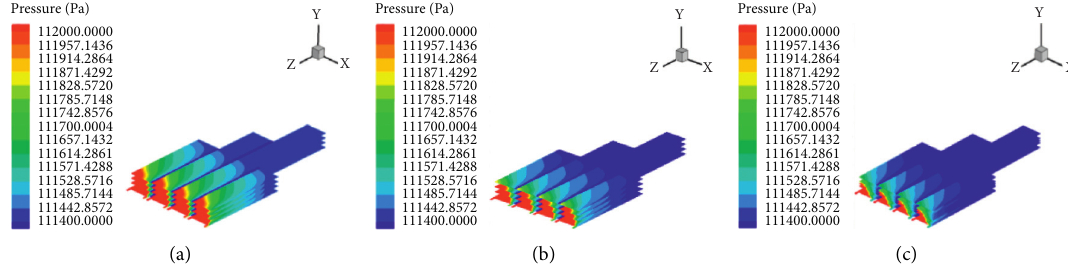
Figure 11: Simulation results of transverse slices at different air inlet pressures. (a) At air inlet pressure of 112400 Pa. (b) At air inlet pressure of 112000 Pa. (c) At air inlet pressure of 111800 Pa.